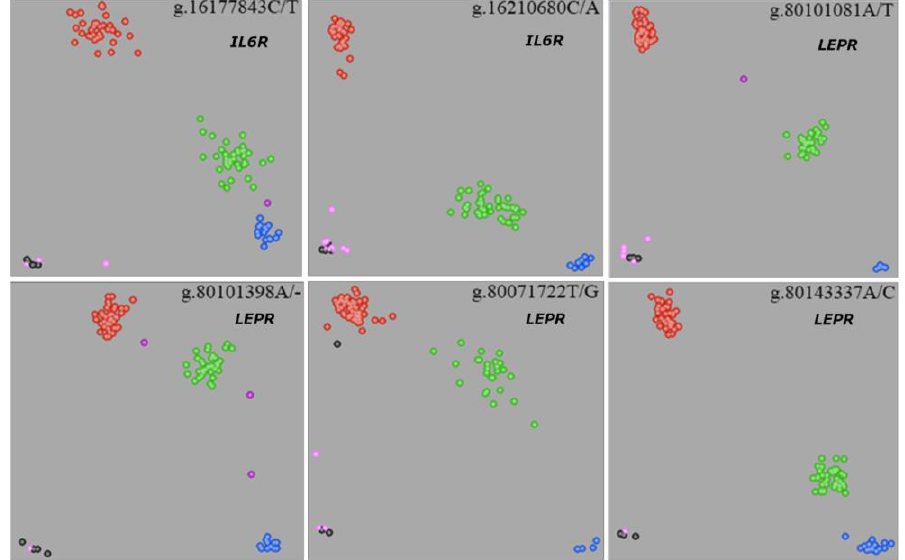
Figure 1. Distributions of SNP clustering for the identified six SNPs IL6R and LEPR using KASP genotyping method. The red and blue represents two homozygous genotypes; the green represents heterozygous genotype; the pink represents no or weak signal; the purple represents signal for no genotyping; and the black represents blank